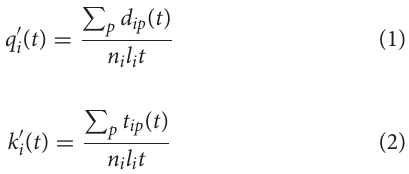
between traffic flow and density in large urban networks. The formulations of road flow and density refer to Saffari et al. (